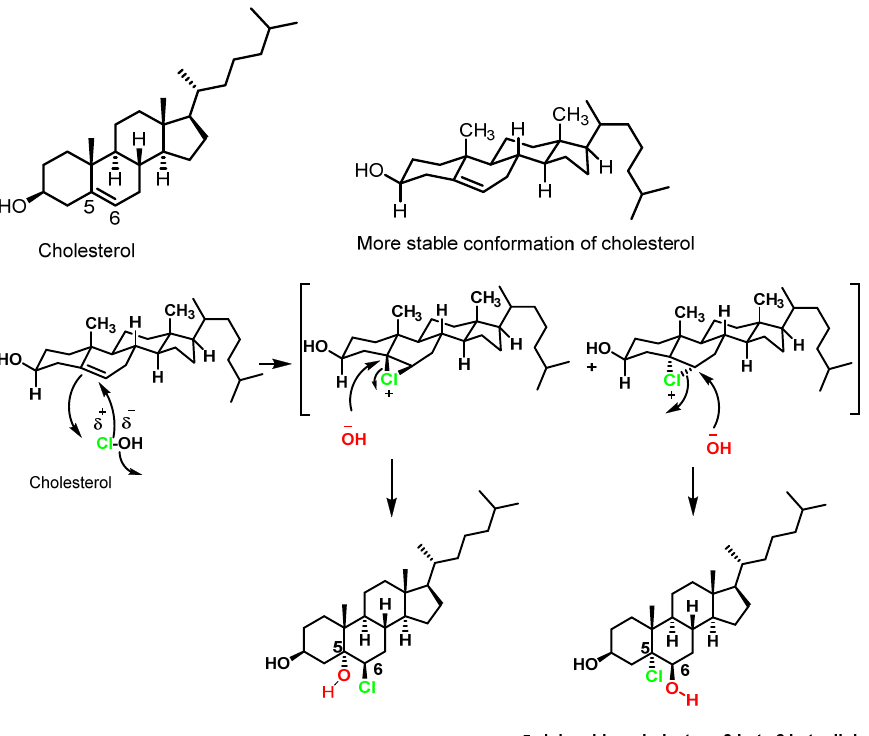
Figure 8. Electrophilic addition of HOCl to cholesterol. Mechanism of formation of cholesterol chlo- rohydrins.